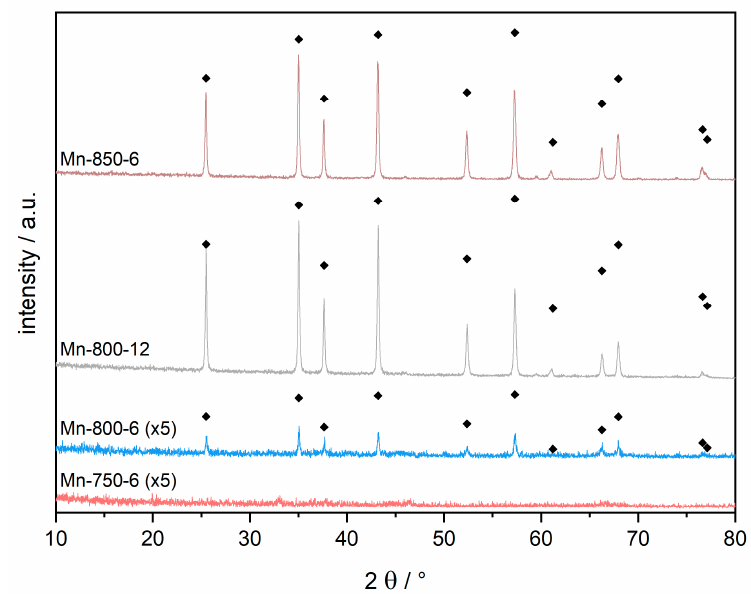
Figure 2. XRD patterns of Mn-impregnated samples after calcination at 750–850 ◦ C for 6 or 12 h. Figure 2. XRD pa tt erns of Mn-impregnated samples after calcination at 750–850 °C for 6 or 12 h. Patterns of samples Mn-750-6 and Mn-800-6 are expanded ( × 5) for better visibility. Black rhombs Pa tt erns of samples Mn-750-6 and Mn-800-6 are expanded (×5) for be tt er visibility. Black rhombs mark corundum reflexes. mark corundum re fl exes.